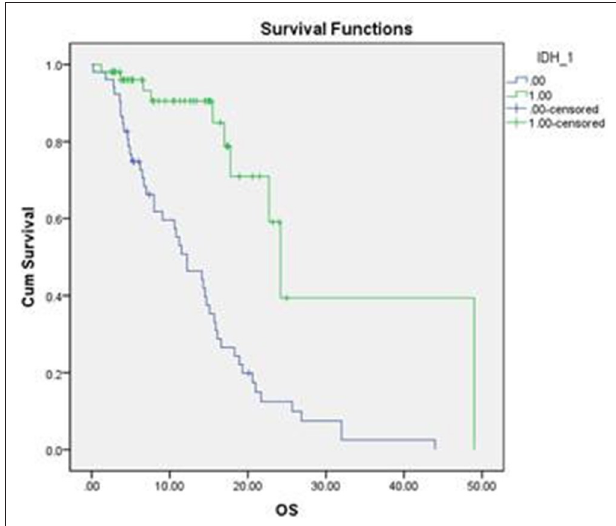
FIGURE 4 | Survival curves associated with IDH1 mutation. The overall survival of IDH1 mutant glioma was significantly longer than IDH1 wild-type